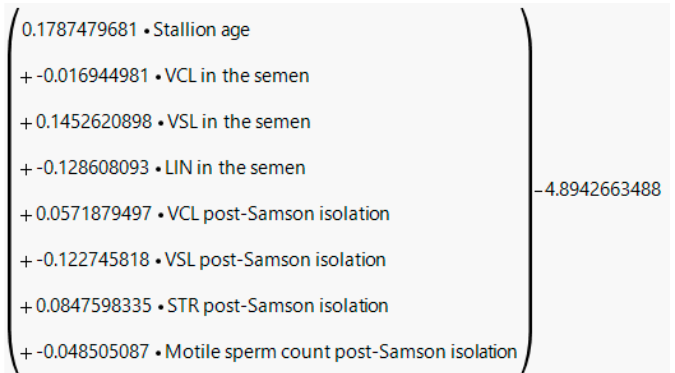
Figure A5. Equation optimized for stallion 4 from the pre-chilled data set: predictive accuracy of 75%.